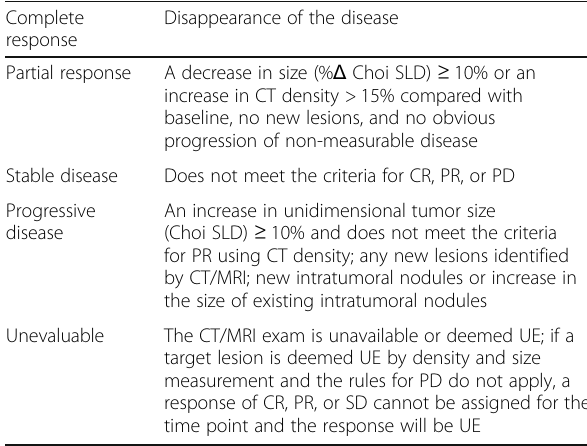
Table 1 Response criteria by inverse Choi